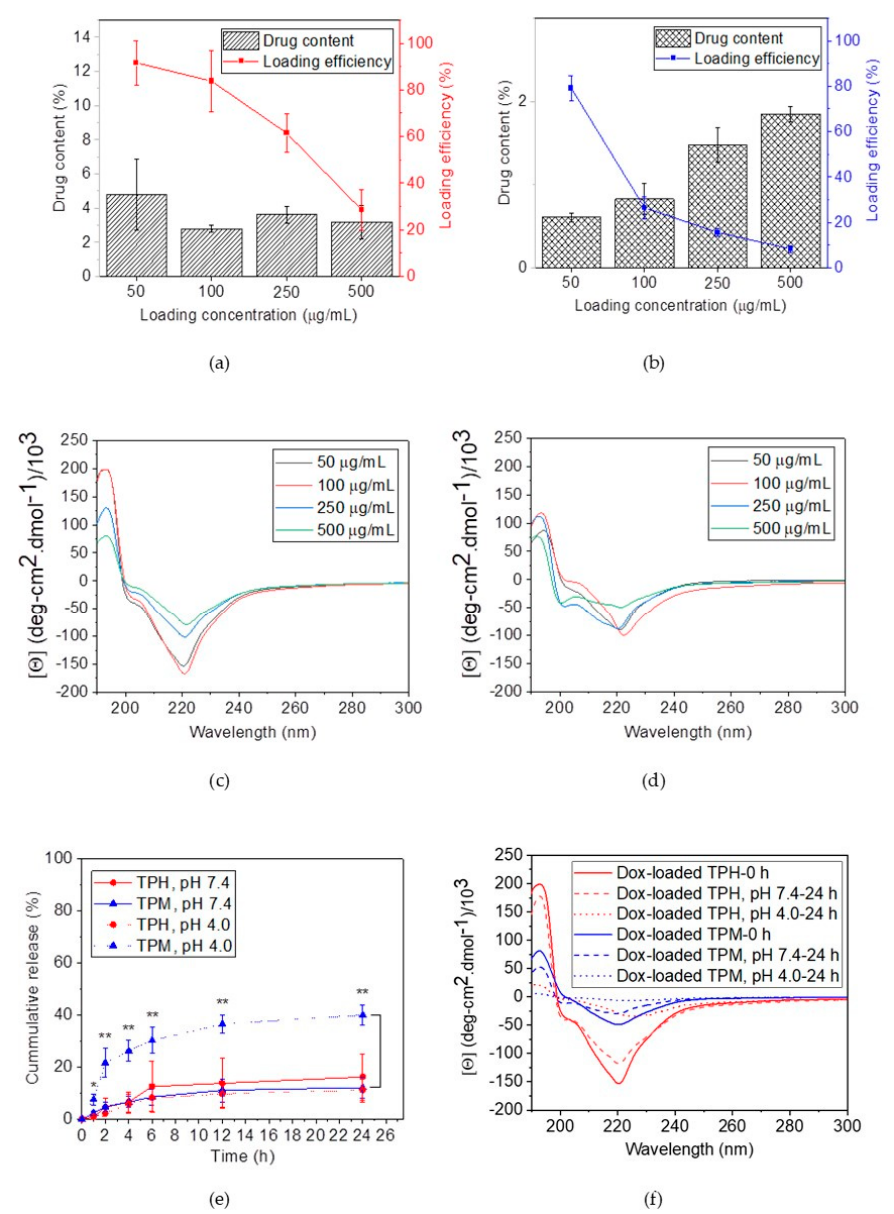
Figure 3. Drug loading and releasing behaviors. The anticancer drug doxorubicin (Dox) was encapsulated into TPH and TPM polymeric mixed micelles. To optimize the drug loading e ffi ciency, various amounts of the doxorubicin were in-feed and the drug contents and e ffi ciency of TPH ( a ) and TPM mixed micelles ( b ) were determined by a UV-vis spectrum. Simultaneously, CD spectrum of TPH ( c ) and TPM ( d ) micelles were also detected. The drug releasing profiles of these mixed micelles at 37 ◦ C in pH 7.4 and 4.0 conditions were also determined using a UV-vis spectrum ( e ). The CD spectrum of the mixed micelles after incubation at pH 7.4 and 4.0 conditions for 24 h were also investigated ( f ). Asterisk markers represent significant di ff erence in statistics (** p <